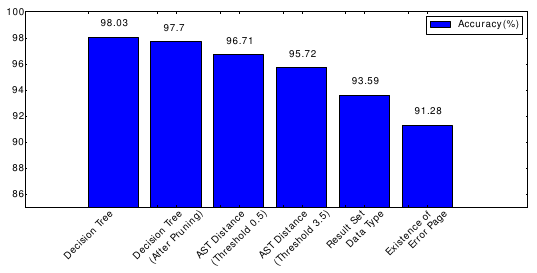
Figure 9. Detection Accuracy Comparison with Single Stage